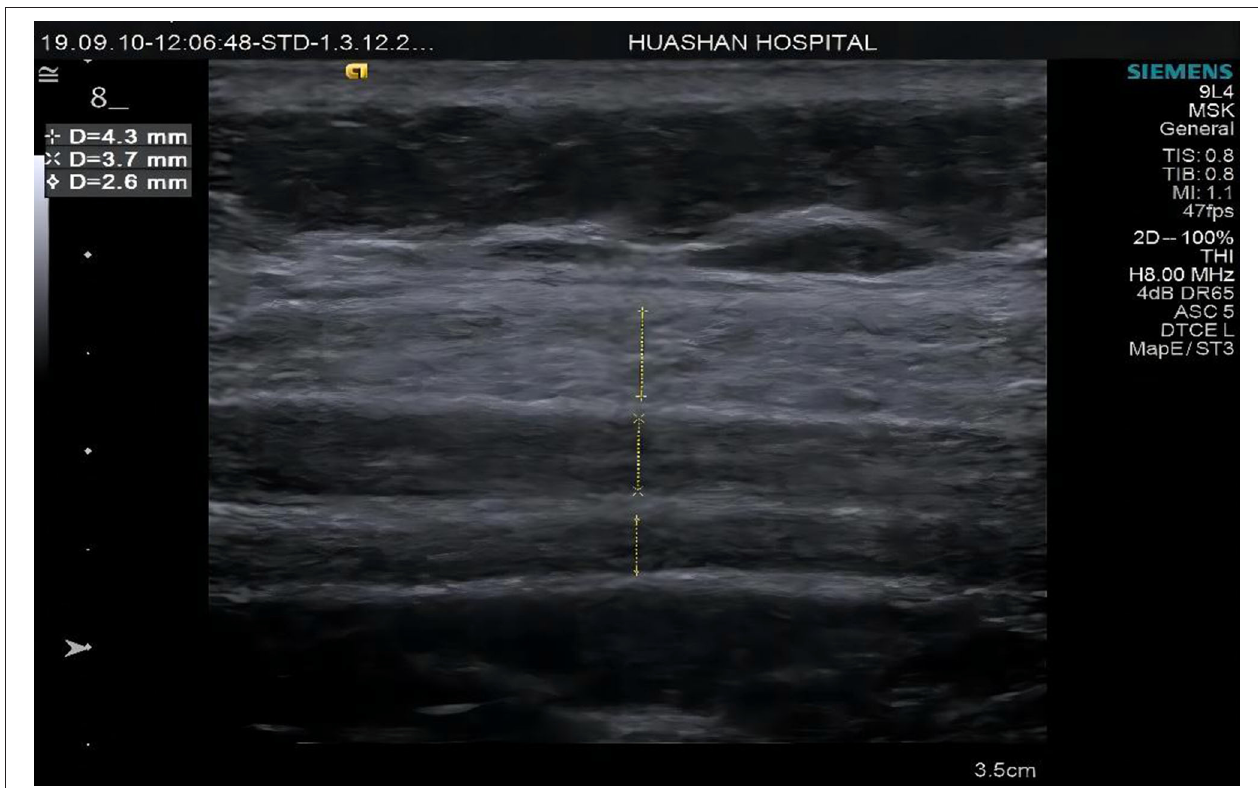
FIGURE 4 | Muscle thickness measurements diagrams of Group A at point 2 external oblique muscle (EO), internal oblique muscle (IO), and transverse abdominis